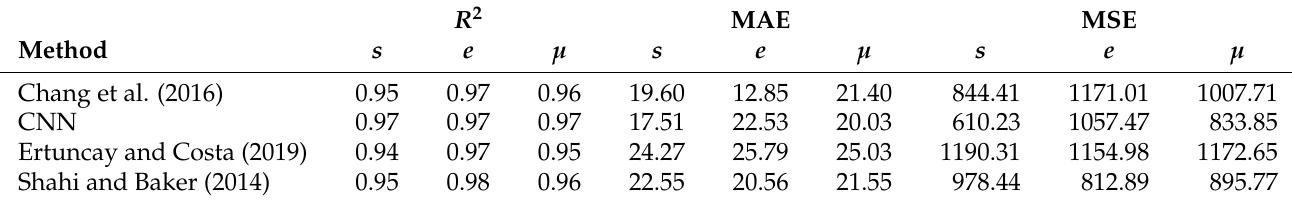
Table 4. Results of all methods averaged among 5-fold cross-validation. R 2 MAE